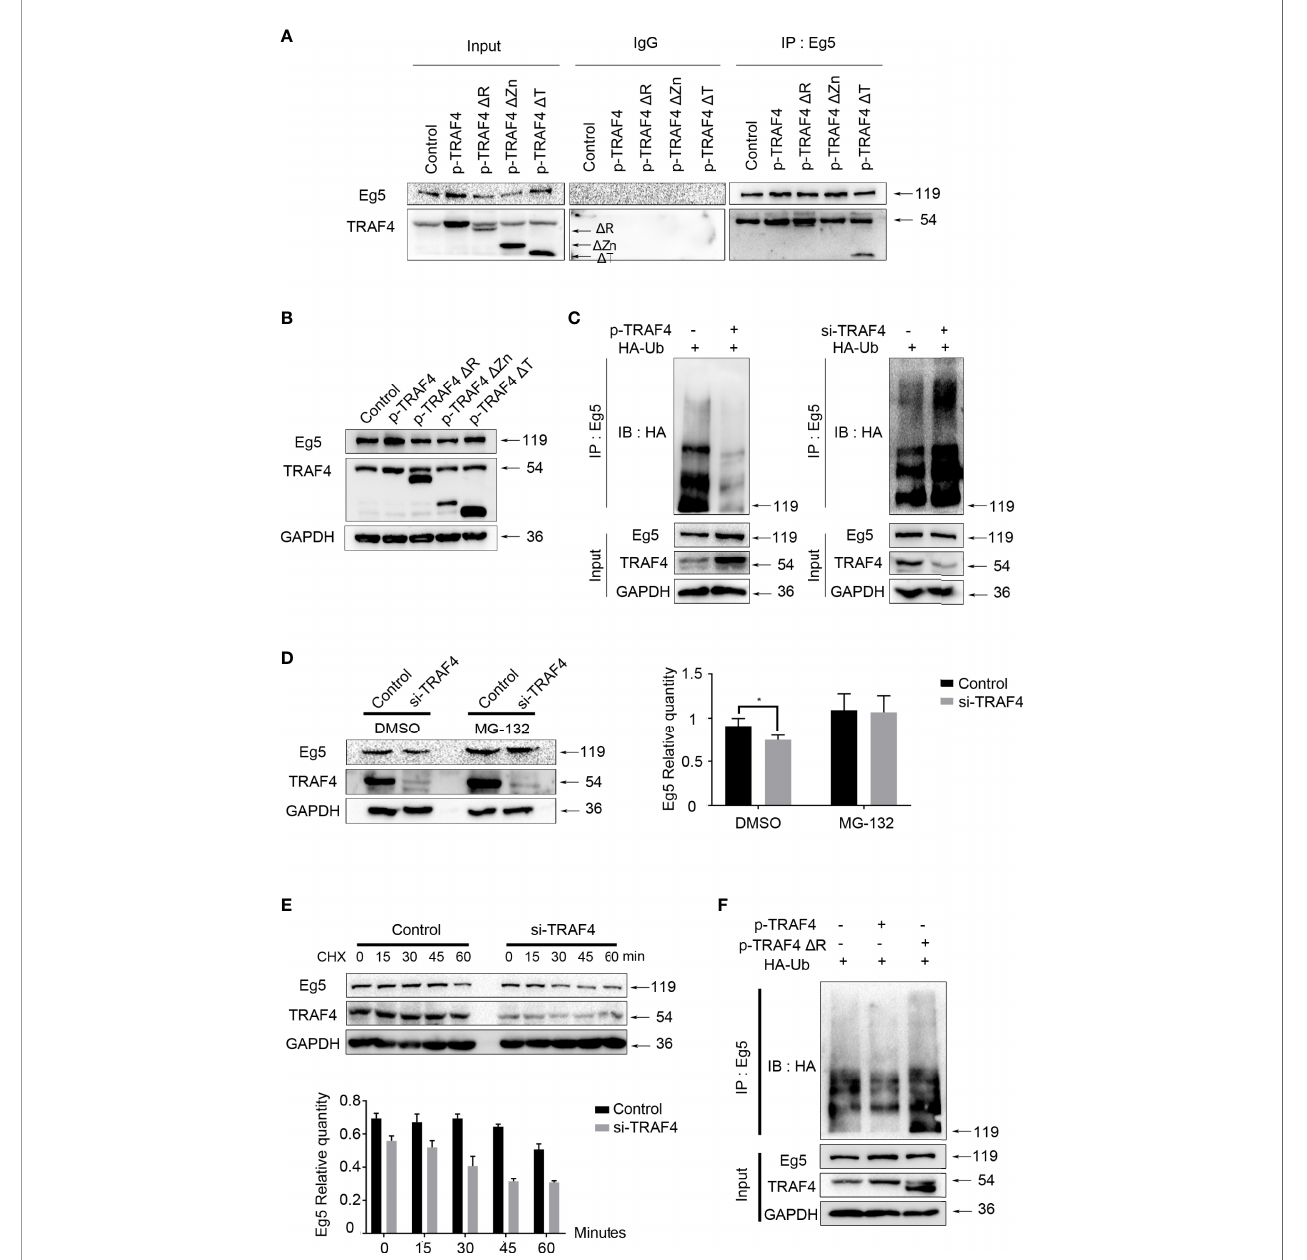
FIGURE 4 | TRAF4 up-regulates Eg5 by inhibiting Eg5 ubiquitination. (A) MCF-7 cells were transfected with wild type TRAF4, TRAF4 D R, TRAF4 D Zn or TRAF4 D T. Co-immunoprecipitation assays were performed using antibodies against Eg5, followed by immunoblotting. (B) Proteins were extracted from MCF-7 cells transfected with wild type TRAF4, TRAF4 D R, TRAF4 D Zn or TRAF4 D T. Western blot assays were used to demonstrate the protein level of TRAF4 and Eg5. GAPDH was used as an internal control. (C) TRAF4 inhibited the ubiquitination of Eg5. MCF-7cells were co-transfected as indicated. Co-immunoprecipitation was carried out to detected the ubiquitination levels of Eg5, followed by western blot analysis using an antibody against HA. (D) TRAF4 protected Eg5 from proteasome-dependent pathway degradation. MCF-7 cells were transfected with TRAF4 si-RNA treated with DMSO or MG132. Western blot assays were performed to evaluate changes in the protein level of TRAF4, Eg5 and GAPDH. Data represent mean ± SD ( n = 3). (* p < 0.05). (E) MCF-7 cells synchronized by thymidine were transfected with Negative control si-RNA or TRAF4 si-RNA, and released in the G2/M phase. Added Cycloheximide at a fi nal concentration of 50mg/ml, and collected cells after 0, 15, 30, 45 and 60 minutes respectively. Western blot assays were performed to evaluate changes in the protein level of TRAF4, Eg5 and GAPDH. (F) Regulation of Eg5 ubiquitination level by TRAF4 was dependent on its RING domain. MCF-7cells were co-transfected with HA-ubiquitin and empty vector or TRAF4 vector or TRAF4 RING domain deletion mutant vector. Co-immunoprecipitation was carried out to detected the ubiquitination levels of Eg5, followed by western blot analysis using an antibody against